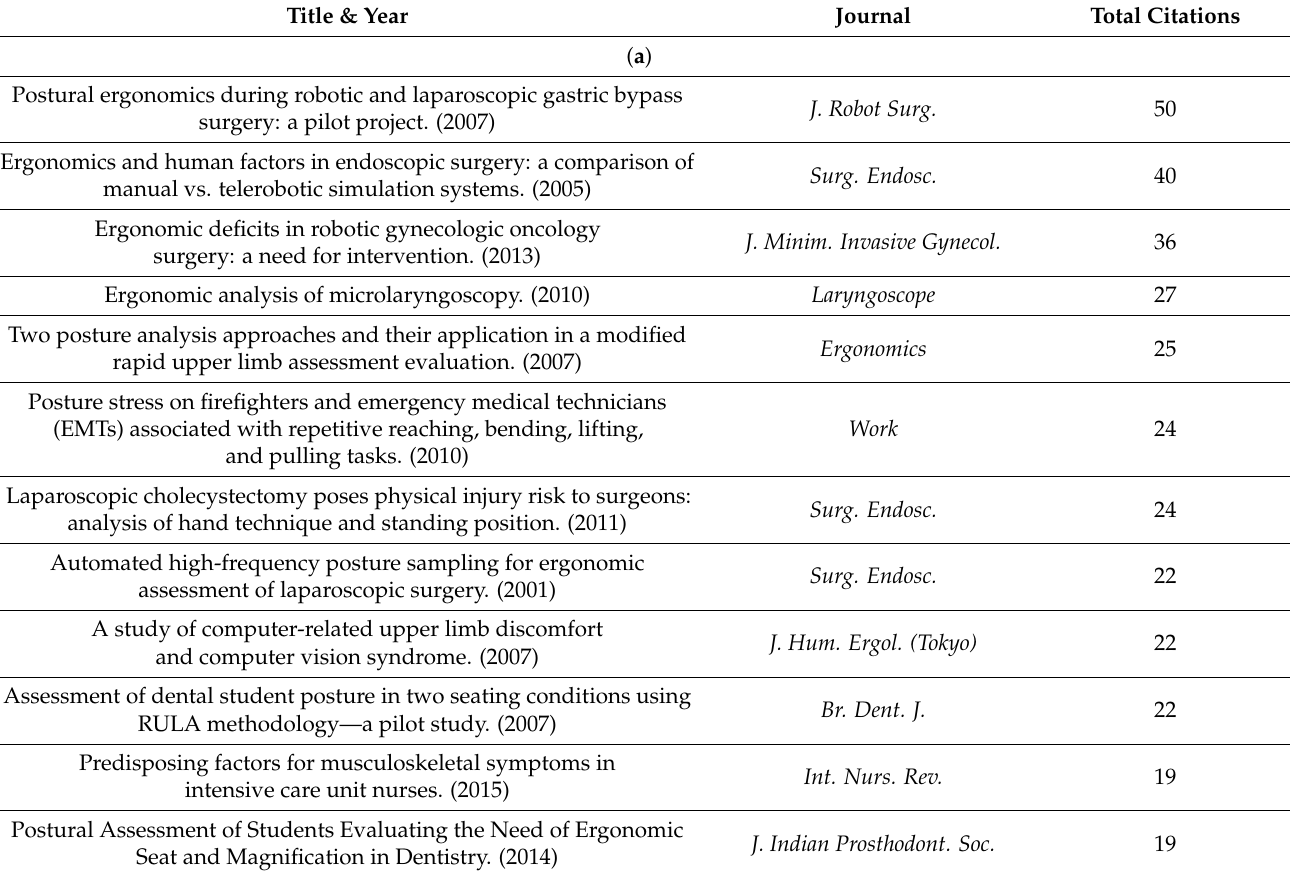
Table 1. (a): List of top 50 cited articles in WMSDS using RULA concerning healthcare